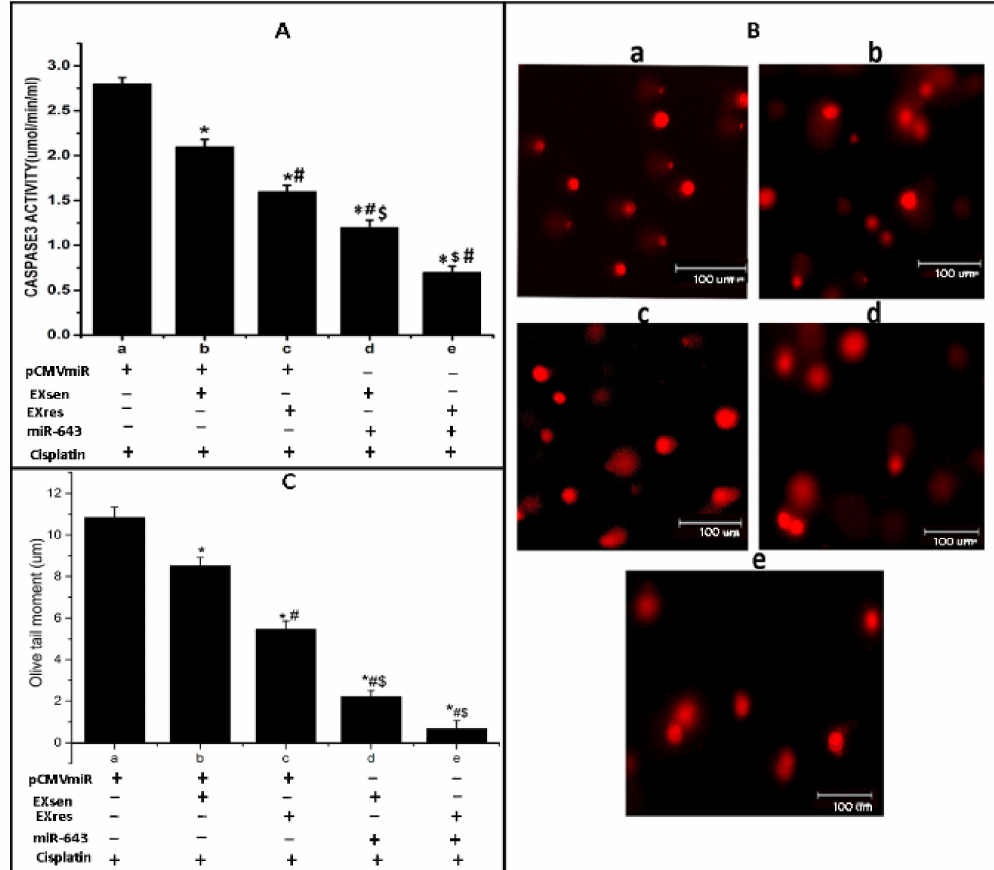
Figure 7. miR-643-mediated, EXres-dependent alteration in cisplatin resistance involves reduced apoptosis, resulting in promotion of cell survival. miR-643 overexpressing Hela cells were treated with EXsen/EXres in the presence of 25 µ M cisplatin for 24 h followed by caspase3 activity assay and comet assay. ( A ). Caspase 3 activity assay. ( B ). Representative microphotographs of comets obtained from comet assay in miR-643 overexpressing Hela cells treated with EXsen/EXres. ( C ). Olive tail moment analysed by comet assay in miR-643 overexpressing Hela cells treated with EXsen/EXres. In ( A – C ), a—vector control + cisplatin, b—vector control + cisplatin+ EXsen, c—vector control + cisplatin + EXres, d—miR-643 overexpressing cells + cisplatin + EXsen and e—miR-643 overexpressing cells + cisplatin + EXres. The mean values of two different experiments ± SEM each performed in triplicate are reported in the graph, p < 0.05. * indicates statistical significance when compared to a. # indicates statistical significance when compared to b. $ indicates statistical significance when compared to